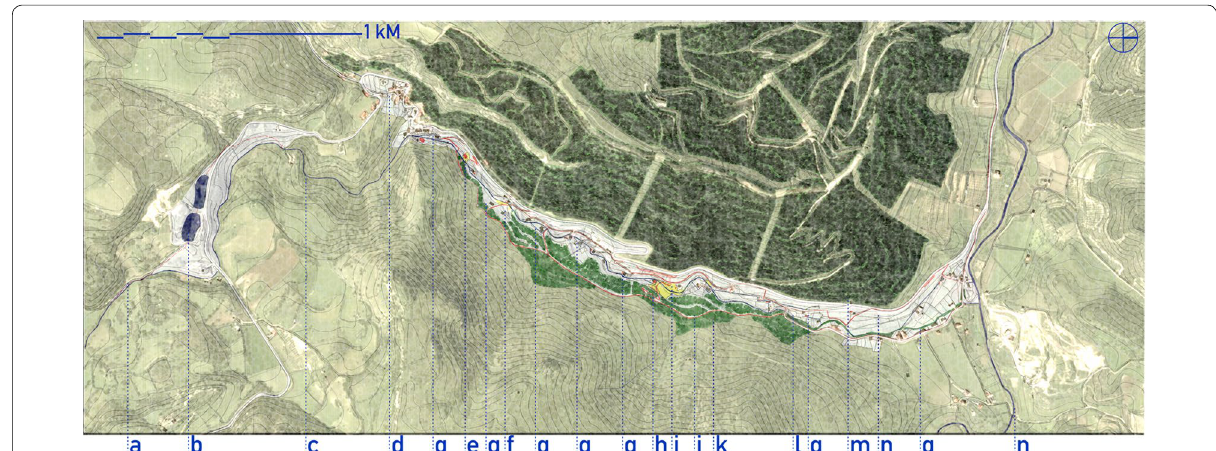
Fig. 1 General plan a San Lorenzo river; b detention reservoirs (former quarries); c Pelton turbine; d San Lorenzo a Monte; e abandoned mill refurbished as mentally impaired children rehabilitation center (proposal); f abandoned mill refurbished as spa (proposal); g groups of privately owned refurbished mills; h abandoned mill refurbished as central building of the "spread-out hotel" (proposal); i main parking area, water lift, access tower; j pedestrian paths; k reforestation to avoid slope erosion (proposal); l substitution of the narrow concrete channel with staggered gabion walls; m existing reforestation; n main road; o Silis